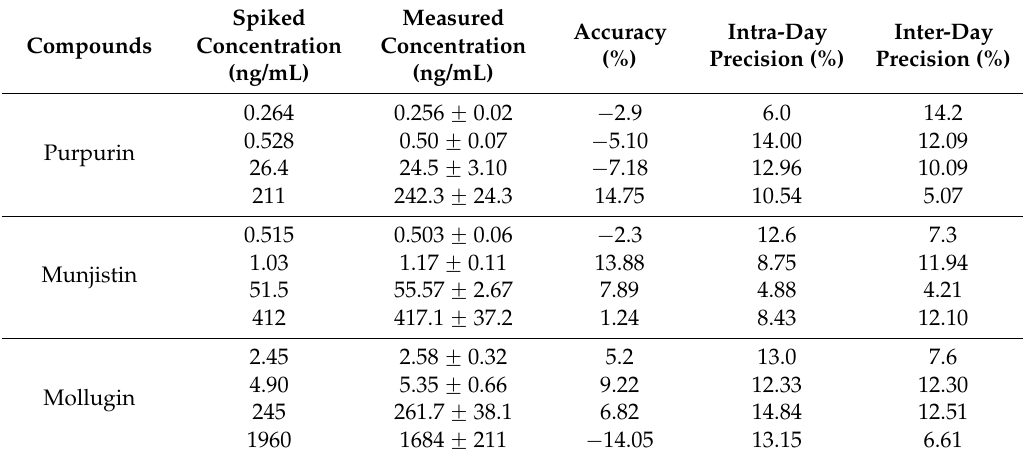
Table 3. Precision and accuracy of the determination of purpurin, munjistin, and mollugin in rat plasma ( n = 18, 6 replicates per day for 3 days). Measured Spiked Accuracy Intra-Day Inter-Day Concentration Compounds Concentration (%) Precision (%) Precision (%) (ng/mL) (ng/mL) 0.264 0.256 ˘ 0.02 ´ 2.9 Purpurin